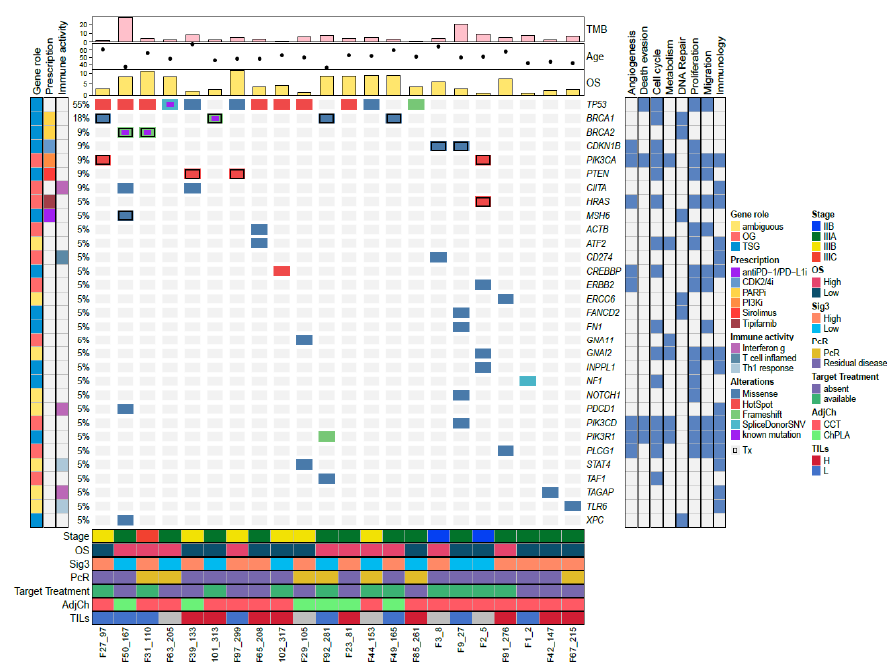
Figure 3. Allelic composition and molecular characteristics of the triple-negative breast cancer (TNBC) samples. Driver mutations are depicted according to the type of mutation (missense, hot spot, frameshift, splicing). Specific mutations already reported in other TNBC studies are shown with the label “known mutation”. Treatment availability for specific mutations is marked with a black frame.